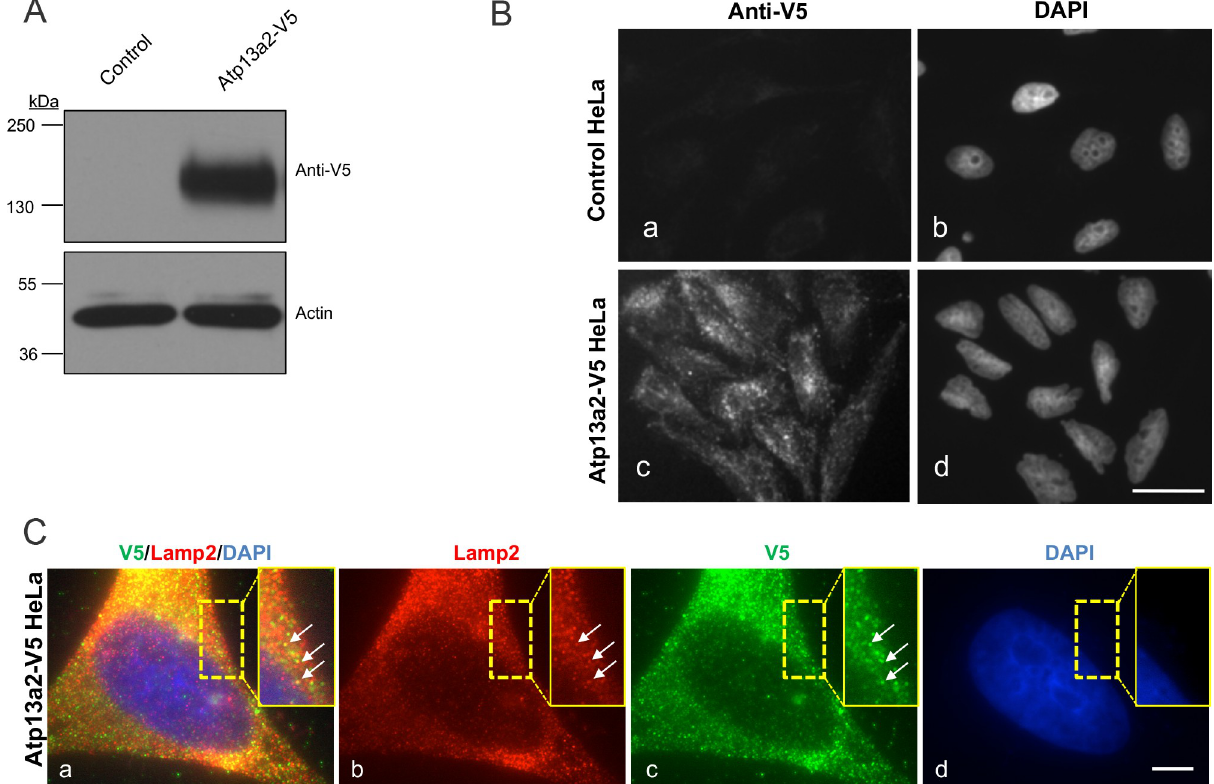
Fig 1. Isolation of a cell line overexpressing human Atp13a2. (A) HeLa cells stably expressing Atp13a2-V5 or the parental control HeLa cells were lysed and equal amounts of protein were probed with a V5 antibody to detect expression of the V5-tagged Atp13a2 protein by immunoblotting. Actin was used to verify protein loading. (B) Control HeLa cells (a and b) or HeLa cells stably expressing Atp13a2-V5 (c and d) were grown on coverslips and stained with the anti-V5 antibody followed by a FITC-conjugated secondary antibody and examined by immunofluorescence microscopy. The anti-V5 antibody decorated puncta in the stable cell line, which is consistent with localization of the Atp13a2-V5 Isoform-1 protein to lysosomes. (C) HeLa cells stably expressing Atp13a2-V5 were double stained with anti-V5 and anti-Lamp 2 antibodies and their binding was detected with Alexa 488-conjugated and Alexa 594-conjugated secondary antibodies. The images shown are of the same cell imaged for the two different fluorescent proteins and DAPI, which was used to stain the nucleus. The result of merging of the three individual channels is also shown. The stippled box is a magnified portion of the cell to better illustrate the colocalization of V5 and Lamp 2 staining (white arrows). Bar, 10 μ